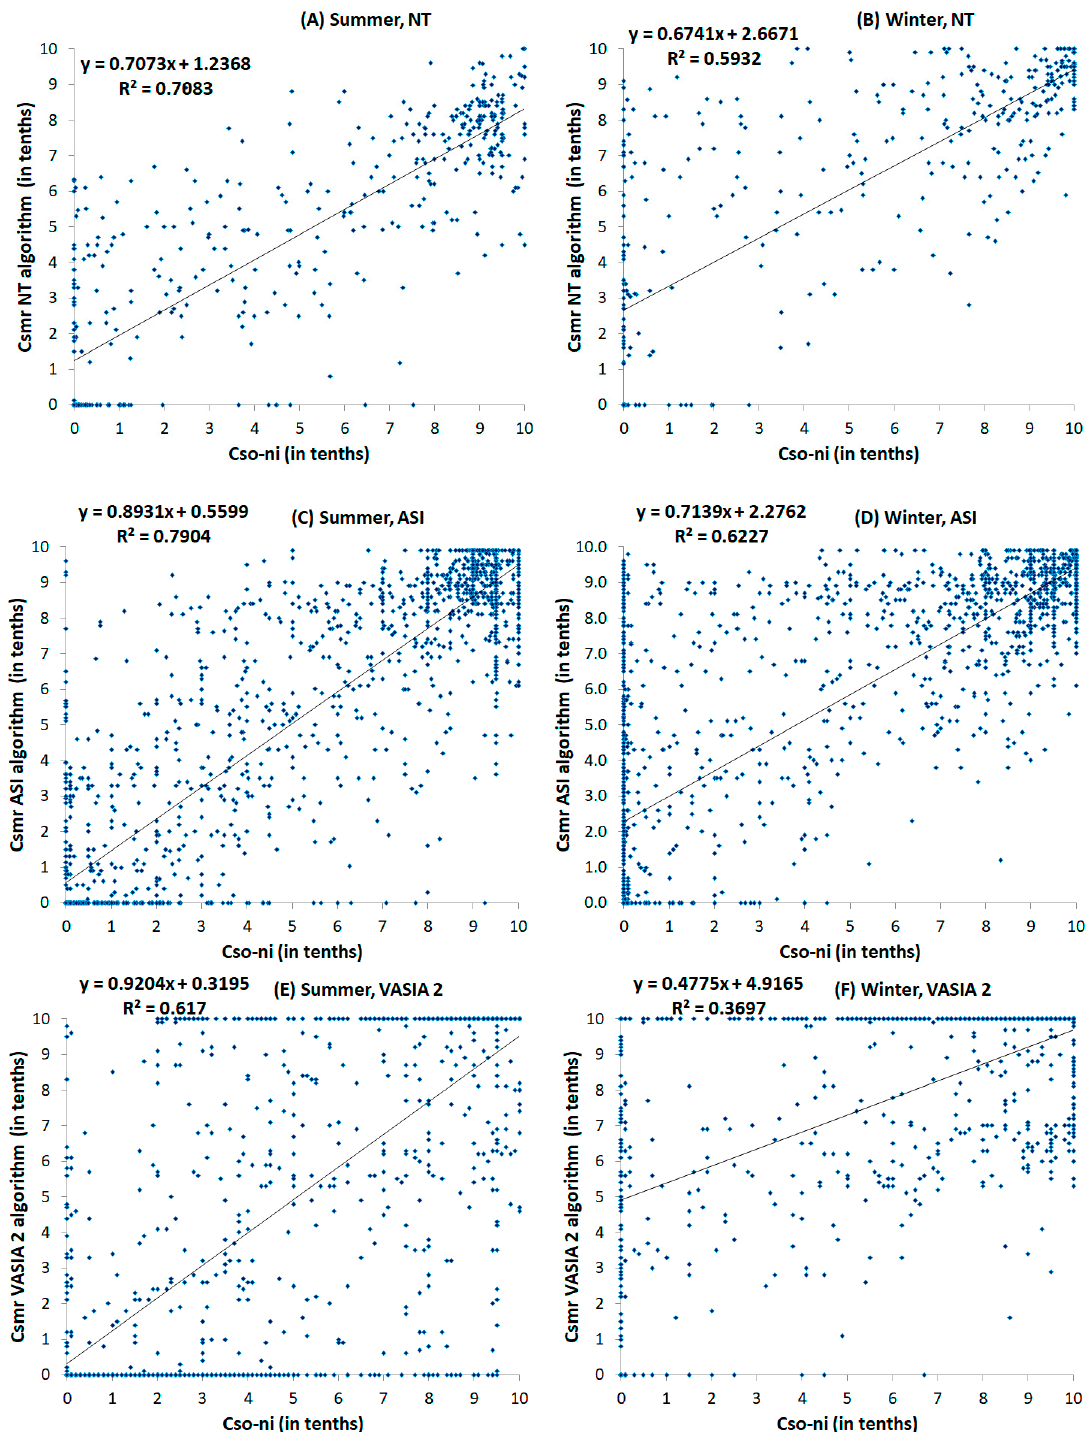
Figure 12. Photo of 20 April 2011, taken on board Kapitan Danilkin cargo vessel in the Kara Sea (east of Cape Gelaniya) by T.A. Alekseeva.